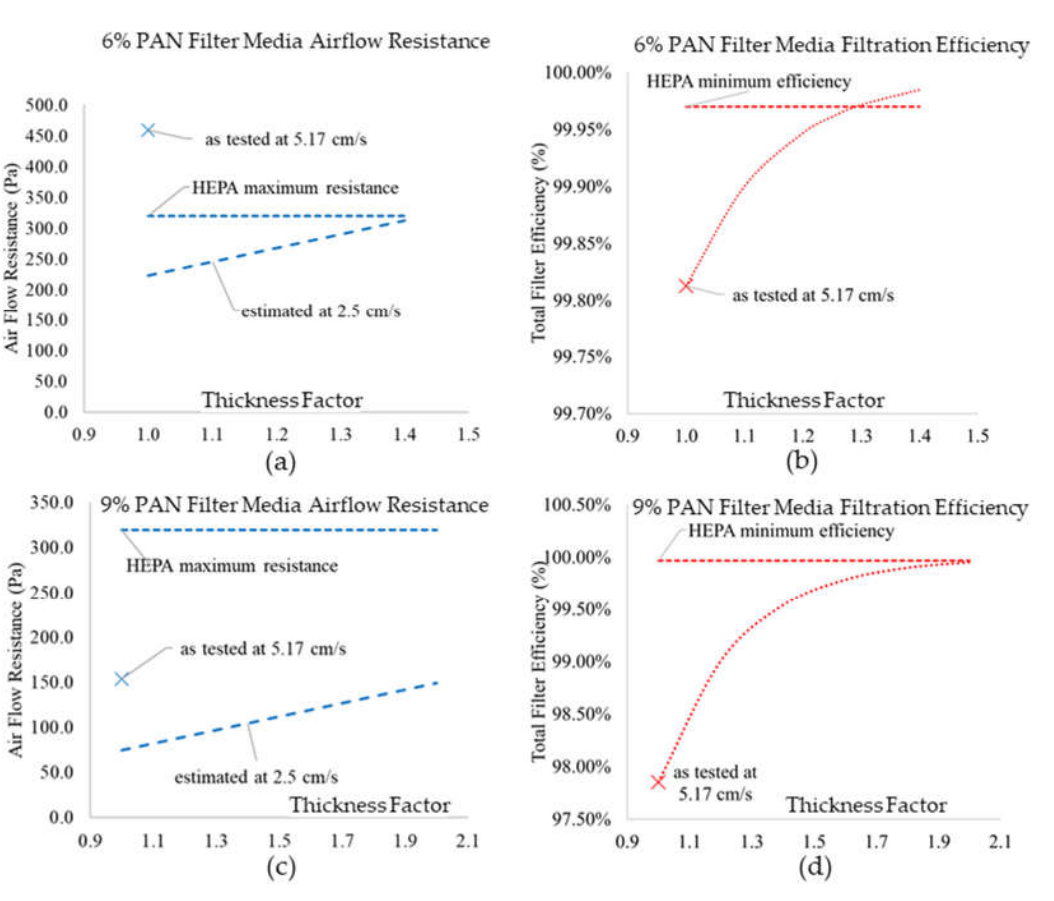
Figure 13. Air filtration efficiency and airflow resistance. ( a ) Airflow resistance of 6% media. ( b ) Filtration efficiency of 6% media. ( c ) Airflow resistance of 9% media. ( d ) Filtration efficiency of 9% media.